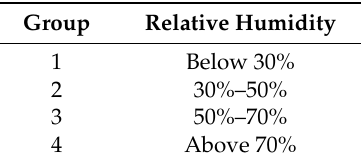
Table 4. Humidity